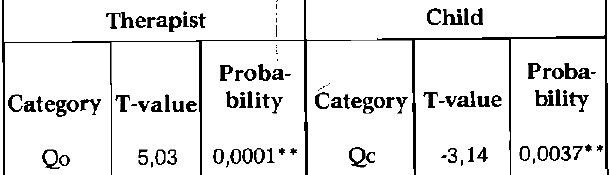
Table 3: Significant differences between means on categories used jby the therapist and child for the first and second testing